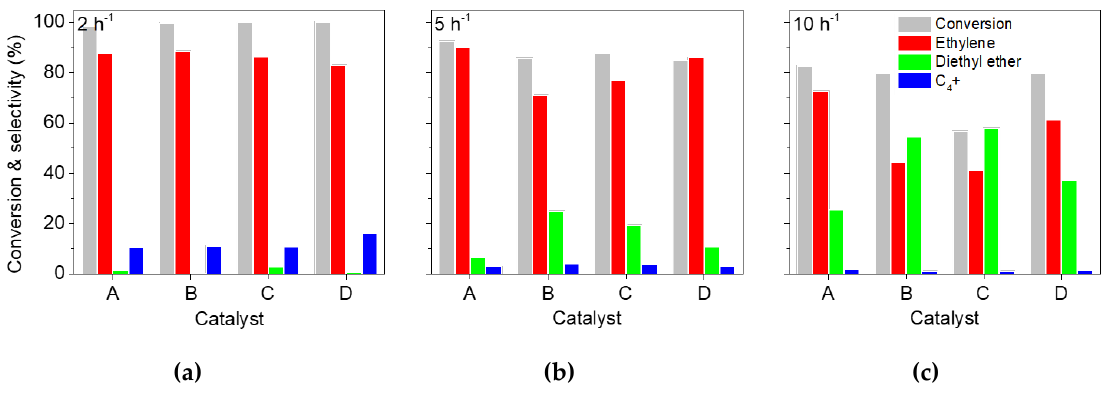
Figure 4. Ethanol conversion ( ■ ) and selectivities to ethylene ( ■ ), diethyl ether ( ■ ), and C 4 + compounds ( ■ ) obtained after 20 h on stream in dehydration of bioethanol over 0.5 g of H-ZSM-5A, H-ZSM-5B, H-ZSM-5C, and H-ZSM-5D at 260 °C and 2 (left), 5 (middle), and 10 h − 1 (right) WHSV.